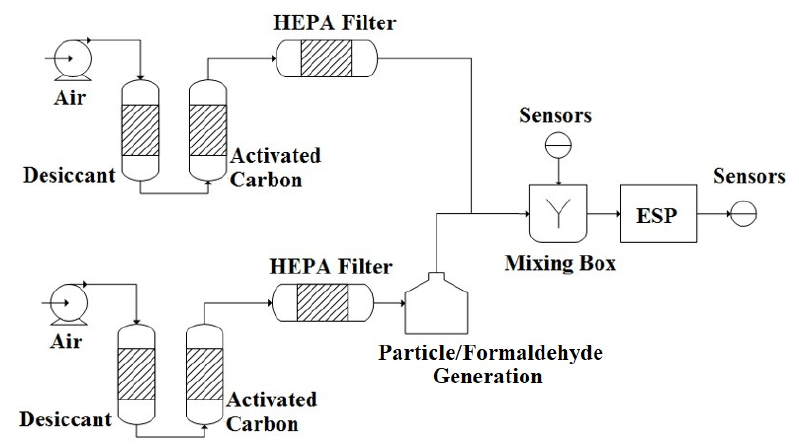
Figure 2. ESP of lab test system.